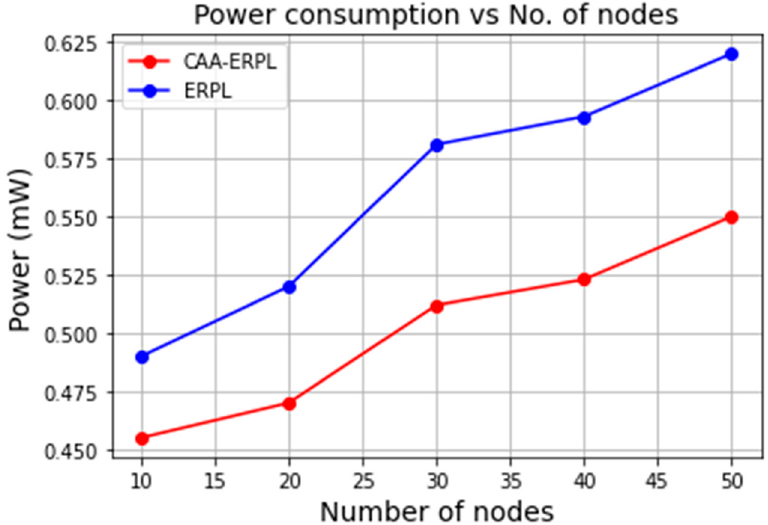
Figure 4. Total power consumption vs. scalability of nodes.